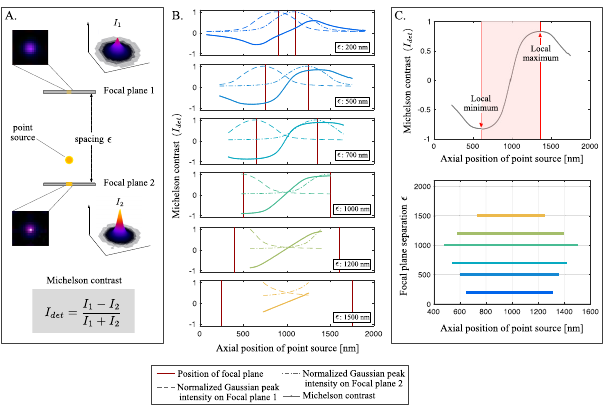
Figure 3. Simulation for evaluating the trackable range of point source (100 nm-diameter) with respect to various (cid:101) values. ( A ) Concept of the (cid:101) spacing between two focal planes. The Michelson contrast ( I det ) is utilized for the ratiometric method, by comparing the Gaussian peak of the intensity distribution on each focal plane; ( B ) I det calculated with various (cid:101) , changed from 200 nm to 1500 nm; ( C ) Trackable range can be determined based on the distance between local minimum and local